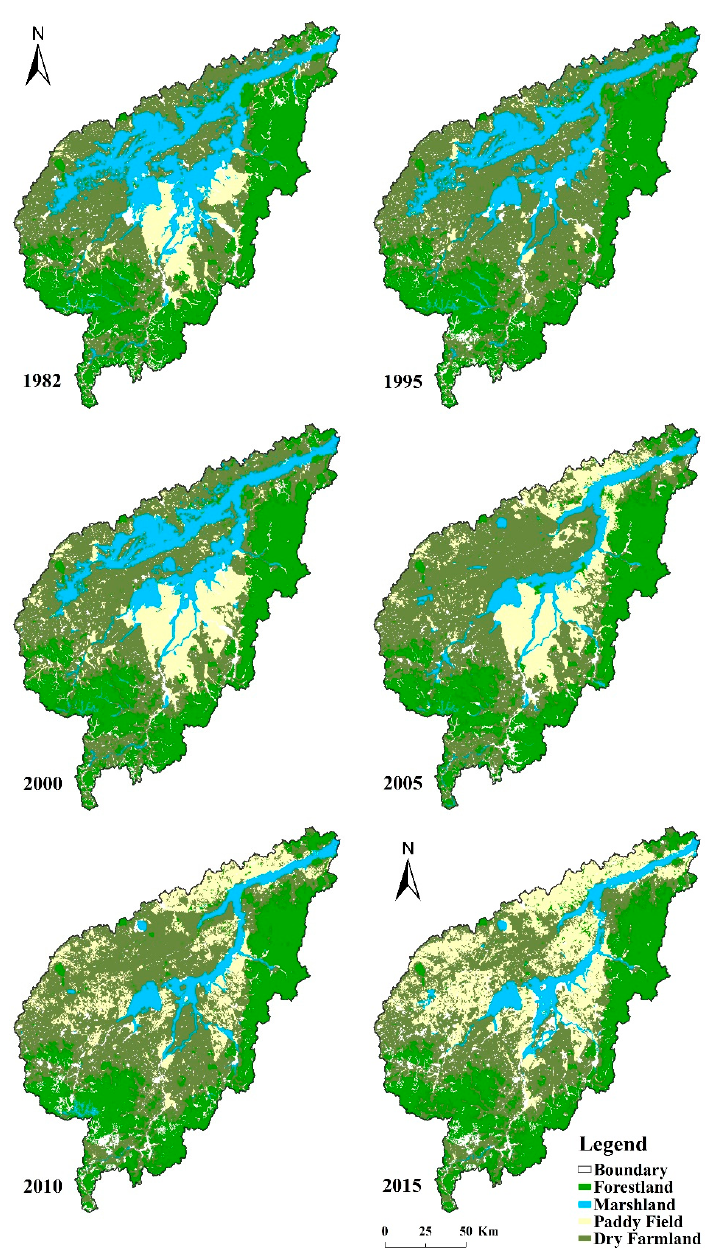
Figure 1. Land use distribution of the Naoli River catchment from 1982 to 2015.